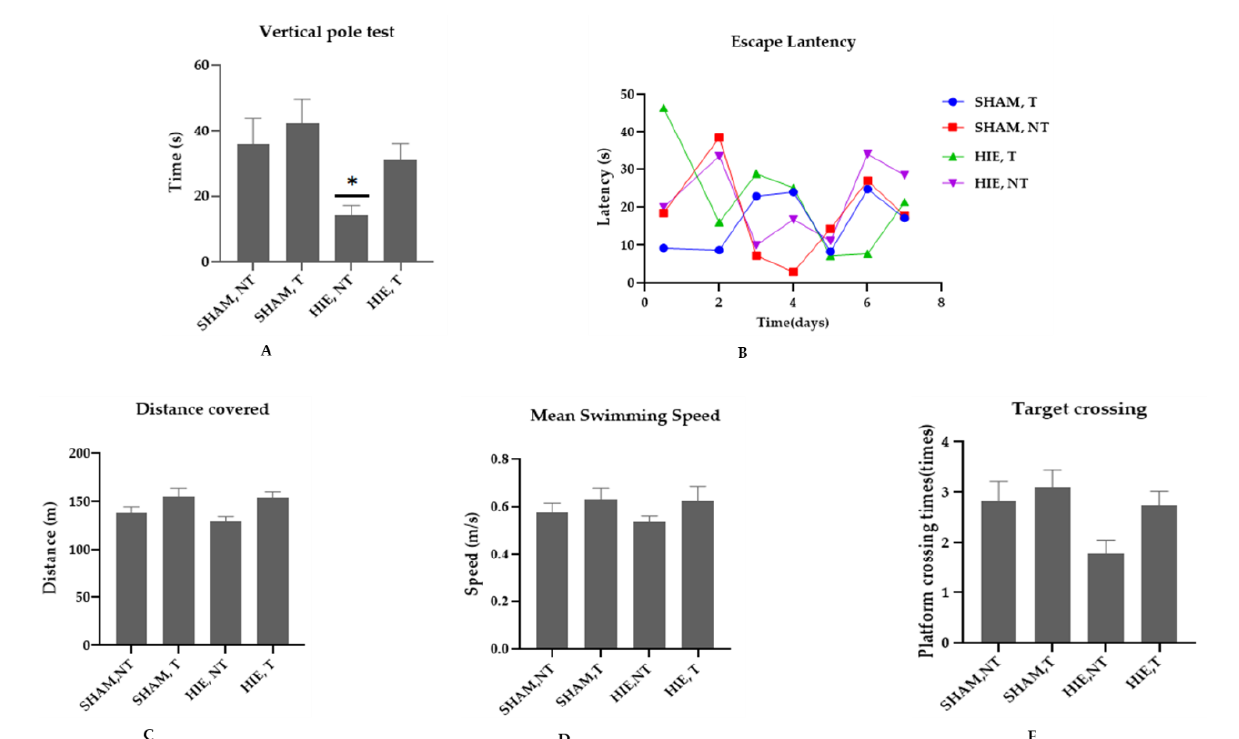
Figure 1. Effect of swimming on motor and cognitive performance . ( A ) Vertical pole test; exercise training animals (SHAM, T and HIE, T) spent longer time on the vertical pole than sedentary animals (SHAM, NT and HIE, NT), with HIE, NT showing a statistically significant decrease; findings are expressed as Mean ± SEM, * p < 0.05 (one-way ANOVA followed by Dunnett’s post-test). ( B ) Escape latency; swimming exercise enhanced learning and memory; exercising animals showed a significantly reduced escape latency, or the time (seconds) required to escape. ( C ) Distance covered; in the exercising groups, there was an obvious increase in distance covered, but it was not statistically significant at p < 0.05 (one-way ANOVA followed by Dunnett’s post-test). ( D ) Mean swimming speed; animal groups that were subjected to exercise showed a higher swimming speed compared to the sedentary groups indicating that their motor behavior was positively influenced by exercise. ( E ) Target crossing; this shows the number of times the animals crossed the site at which the platform had been positioned which as expected improved with exercise. The results are expressed as Mean ± SEM. The number of animals used in each group is 7, but the difference was not statistically significant at p < 0.05 (one-way ANOVA followed by Dunnett’s